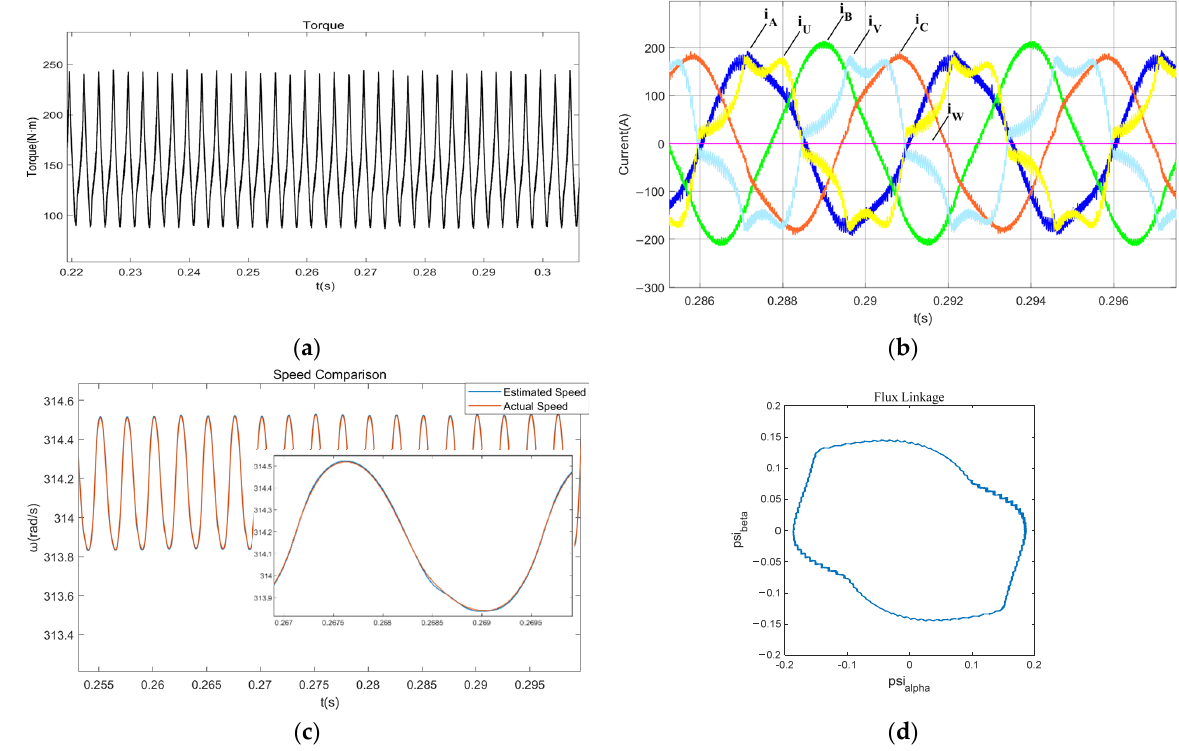
Figure 6. Simulation results under W-phase open circuit. ( a ) Torque; ( b ) phase current; ( c ) speed comparison; ( d ) flux.